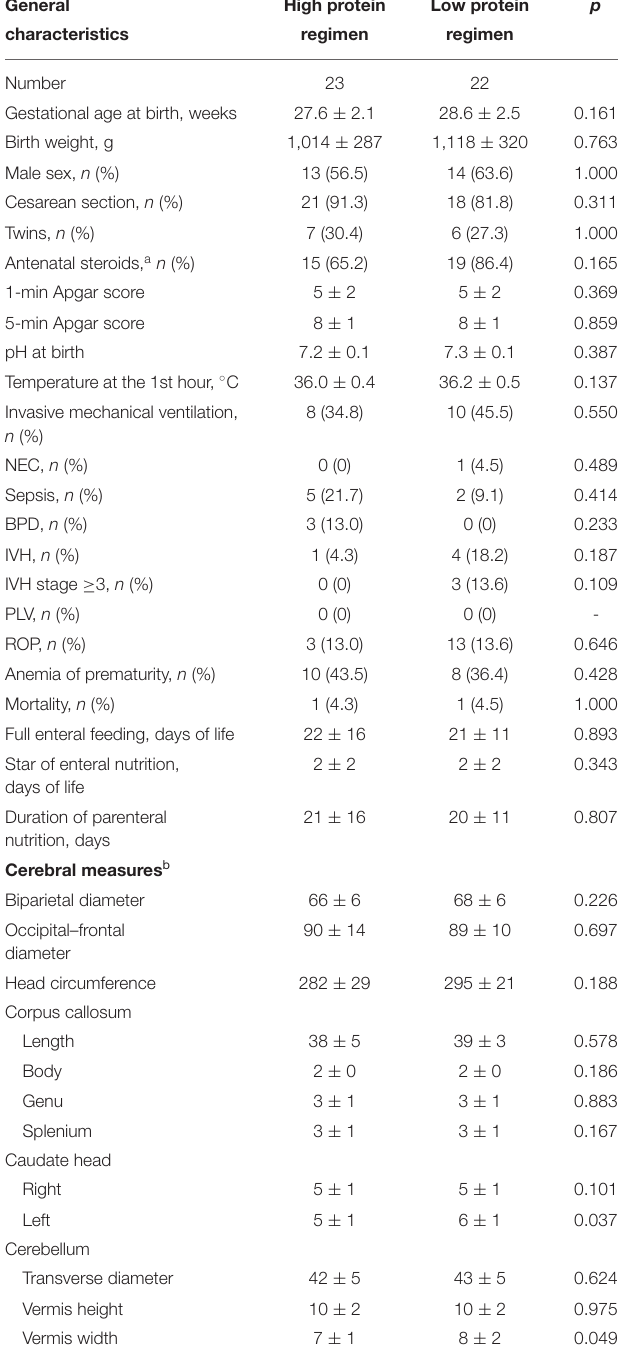
TABLE 4 | Effects of different protein intake in parenteral nutrition on cerebral measures. General High protein Low